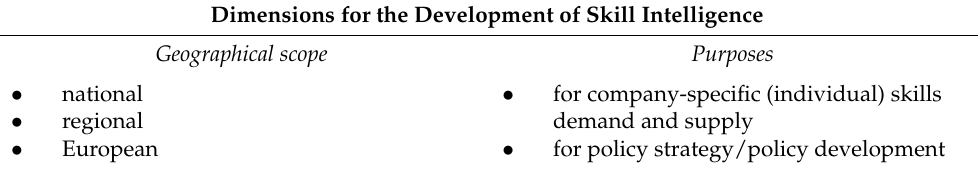
Table 1. Two dimensions of skills intelligence